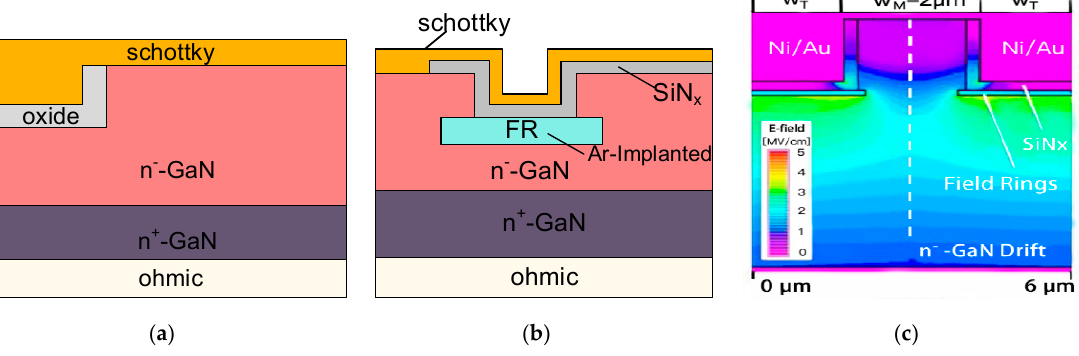
Figure 7. Schematic cross-section of vertical GaN TMBS: ( a ) typical structure, ( b ) FR-TMBS structure, and ( c ) simulated E-field distribution of FR-TMBS at − 1000 V.